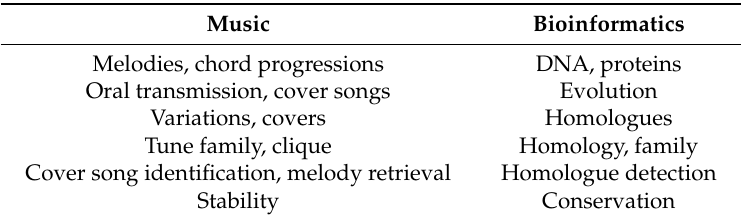
Table 1. Shared concepts and terms between music and